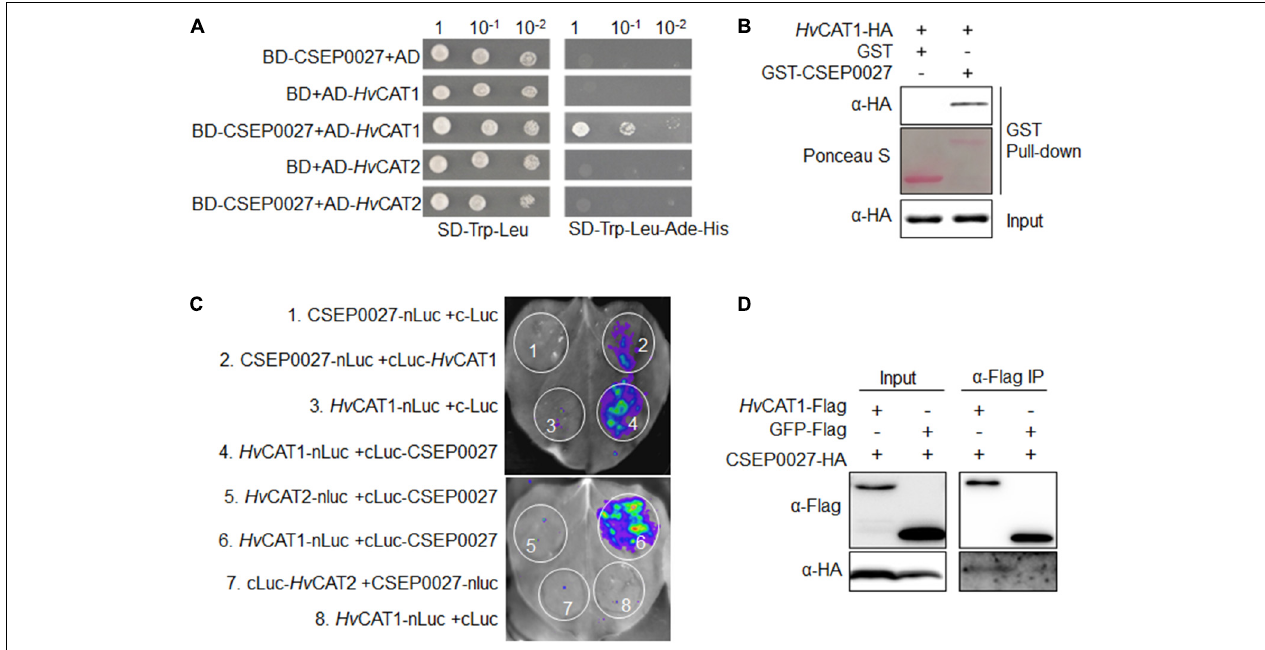
FIGURE 4 | CSEP0027 specifically interacts with barley catalase Hv CAT1. (A) Yeast two-hybrid (Y2H) assay shows CSEP0027- Hv CAT1 interaction. Yeast was transformed with indicated bait and prey constructs. Serial dilutions from cell suspension of yeast expressing bait and prey constructs are shown. Growth on SD-Trp-Leu plates indicates yeast clones carrying the bait and prey constructs. The interactions were detected as yeast growth on SD-Trp-Leu-Ade-His plates. (B) Glutathione S-transferase (GST) pull-down assay confirms CSEP0027- Hv CAT1 interaction. Hv CAT1-HA was extracted from N. benthamiana leaves at 2 dpi, while GST-CSEP0027 and GST alone were purified from E. coli . GST pull-down fractions were detected by immunoblotting using anti-HA antibody and by Ponceau staining. (C) LCI assay confirms CSEP0027- Hv CAT1 interaction. The N- or C- terminal fragment of LUC (nLuc or cLuc) was fused with indicated proteins. Indicated fusion pairs were coexpressed in N. benthamiana by agroinfiltration. The luminescent signal was collected at 48 hpi with a charge-coupled device (CCD) imaging apparatus. (D) Co-immunoprecipiation (Co-IP) analysis validates CSEP0027 and Hv CAT1 interaction. Hv CAT1-Flag or GFP-Flag was transiently coexpressed with CSEP0027-HA in N. benthamiana . The crude proteins were extracted at 48 hpi and subjected to Co-IP